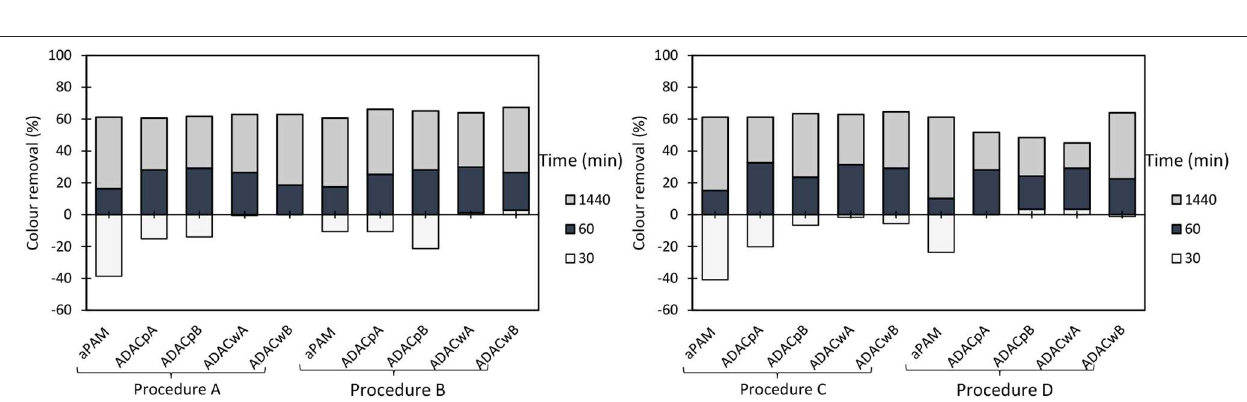
FIGURE 9 | Turbidity removal of industrial effluent as a function of time of settling, using anionic cellulose-based flocculation agents from bleached pulp (ADAC p A and B) and from wood chips (ADAC w A and B), in a dual system with bentonite, at pH 3.0. Procedure A: 0.3 wt% bentonite followed by 2.67 mg/L of flocculant. Procedure B: 0.6 wt% bentonite and 5.34 mg/L of flocculant. Procedure C: 0.3 wt% bentonite and 5.34 mg/L of flocculant. Procedure D: 0.6 wt% bentonite and 2.67 mg/L of flocculant. An anionic synthetic aPAM (in a dual system with the same concentrations described in procedures A-D), was used as reference.